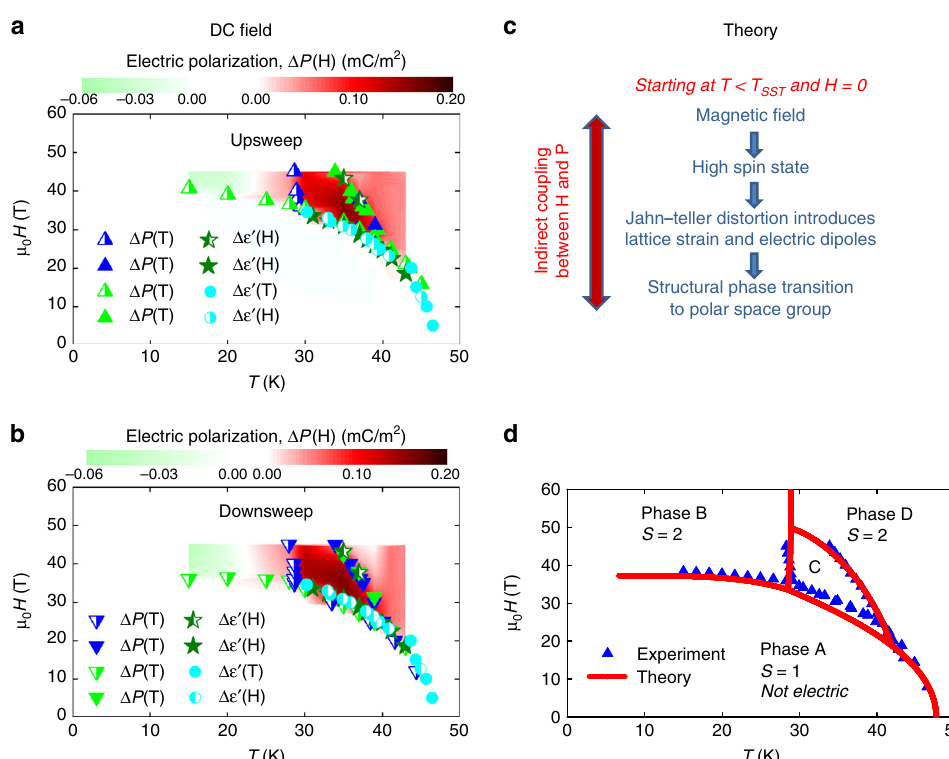
Fig. 5 a , b Magnetic fi eld H vs temperature T phase diagram of Mn(taa) for E || H in quasi-DC magnetic fi elds for up- and downsweeps. The color-mapped regions show the surface charge change relative to the low spin state. In the green region, Δ P switches sign relative to the red region. The data points in a , b are phase transitions de fi ned as the in fl ection points in Δ P ( H , T ) and Δ ϵ ′ ð H ; T Þ . c Outline of the magnetoelectric coupling process for creating a net electric polarization in the high spin state. d Calculated mean- fi eld phase diagram compared to experimental data points averaged between up and downsweeps of the fi eld. The error bars are calculated by averaging over multiple measurements and samples and are smaller than the data